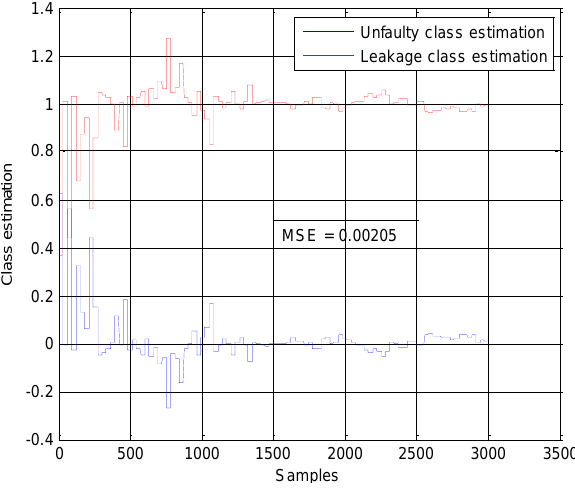
Figure 8. Engine_speed = 1000 rpm and torque = 110 Nm.